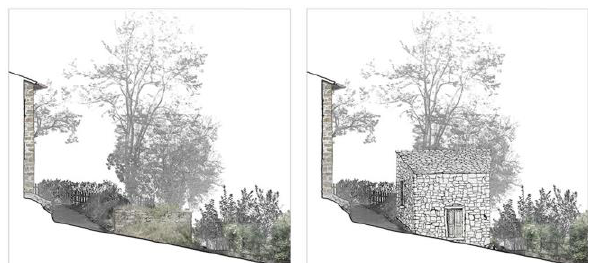
Figure 4. Survey elevation on the road, of the source before the restoration of the area, and 3A. with the design of the small building (Dryer) made when it was still intact, 1986